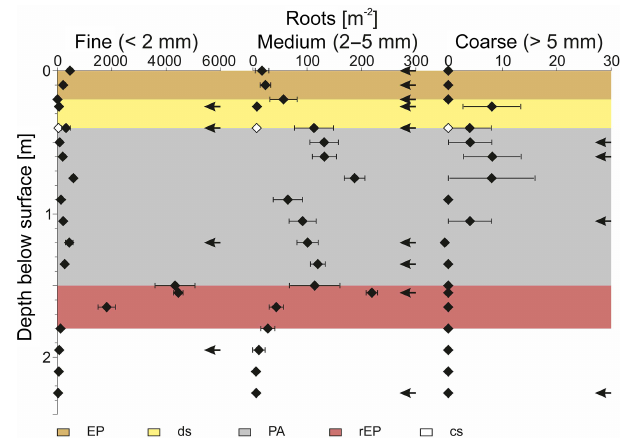
Figure 6. Depth distribution of living roots, quantified on hor- izontal levels, and presence of decomposed roots (if abundant; < 10m − 2 not counted), marked by an arrow. Position of the sym- bols marks the surface of the respective horizontal level. At 0.4m depth, drift sand (white symbols) and PA (black symbols) were an- alyzed separately.